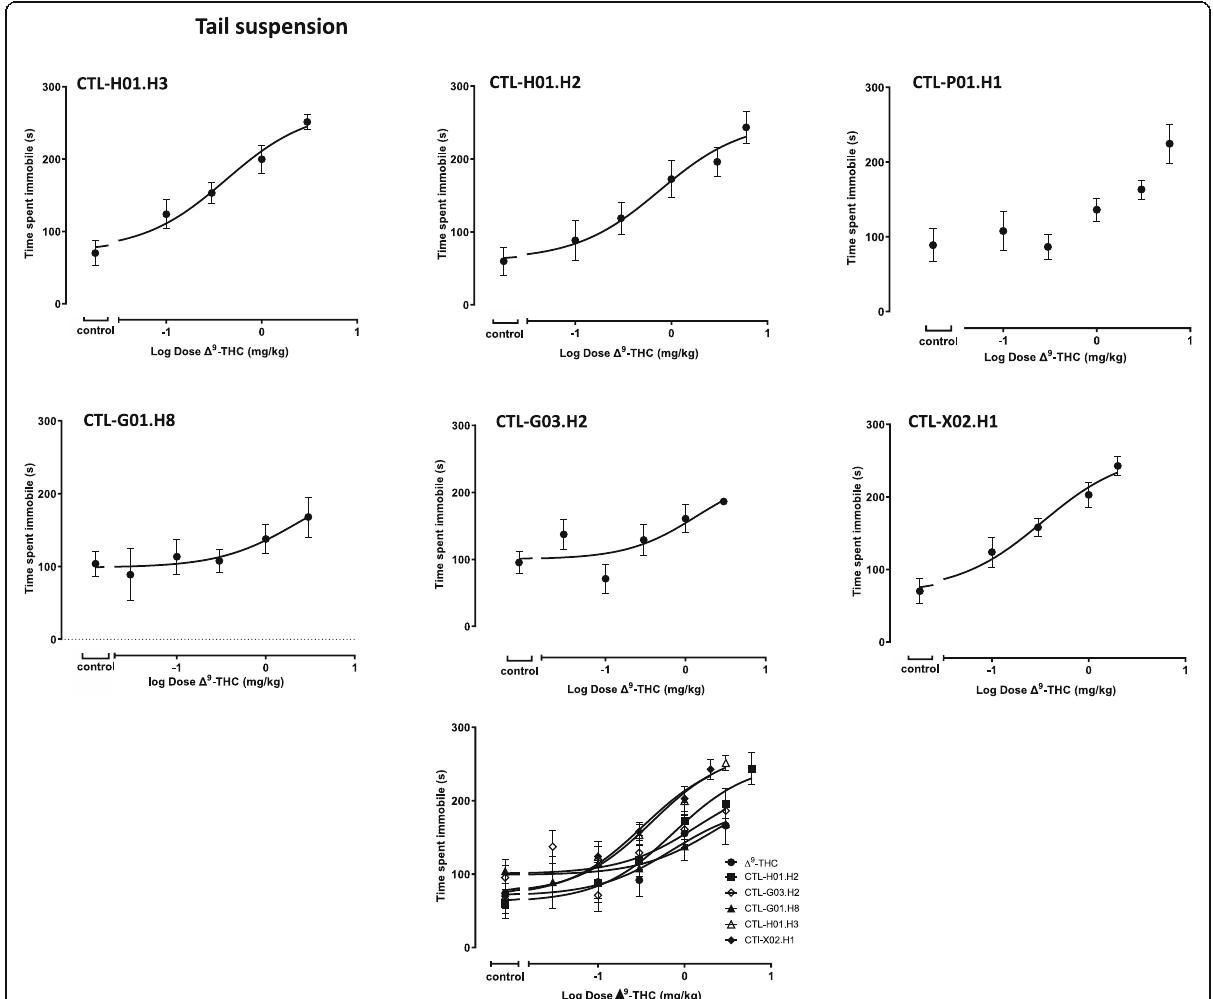
Fig. 3 The effects of cannabis cultivar extracts were examined in the tail suspension assay. Mice were intravenously dosed with control (vehicle) or CTL-H01-H3 (0.1, 0.3, 1 and 3 mg/kg) ( n = 10 per group, 1 animal excluded from 0.01, 0.3, and 1 mg/kg), CTL-H01-H2 (0.1, 0.3, 1, 3 and 6 mg/kg) ( n = 6 per dose with 1 animal excluded from the 0.1 mg/kg group), CTL-P01-H1 (0.1, 0.3, 1, 3 and 6 mg/kg) (n = 6 per group, 2 animals and 1 animal excluded from the 1 mg/kg and 6 mg/kg groups, respectively), CTL-G01-H8 (0.03, 0.1, 0.3, 1 and 3 mg/kg) (n = 6 per group with 1 animal excluded from 0.03, 0.1, 0.3, and 1 mg/kg), CTL-G03-H2 (0.03, 0.1, 0.3, 1 and 3 mg/kg) (n = 6 per group with 1 animal excluded from 1 mg/kg) or CTL-X02-H1 (0.1, 0.3, 1, and 2 mg/kg) (n = 10 per group, 1 animal excluded from 0.01 and 2 mg/kg) cannabis cultivar extract. The curves have been summarized on the same set of axes to facilitate visual comparisons. Immobility time was evaluated 20 min post dose. Data are presented as the mean ± SEM. Data were fit using a 3 parameter log (agonist) vs. response non-linear regression model. Dosing was based on the Δ 9